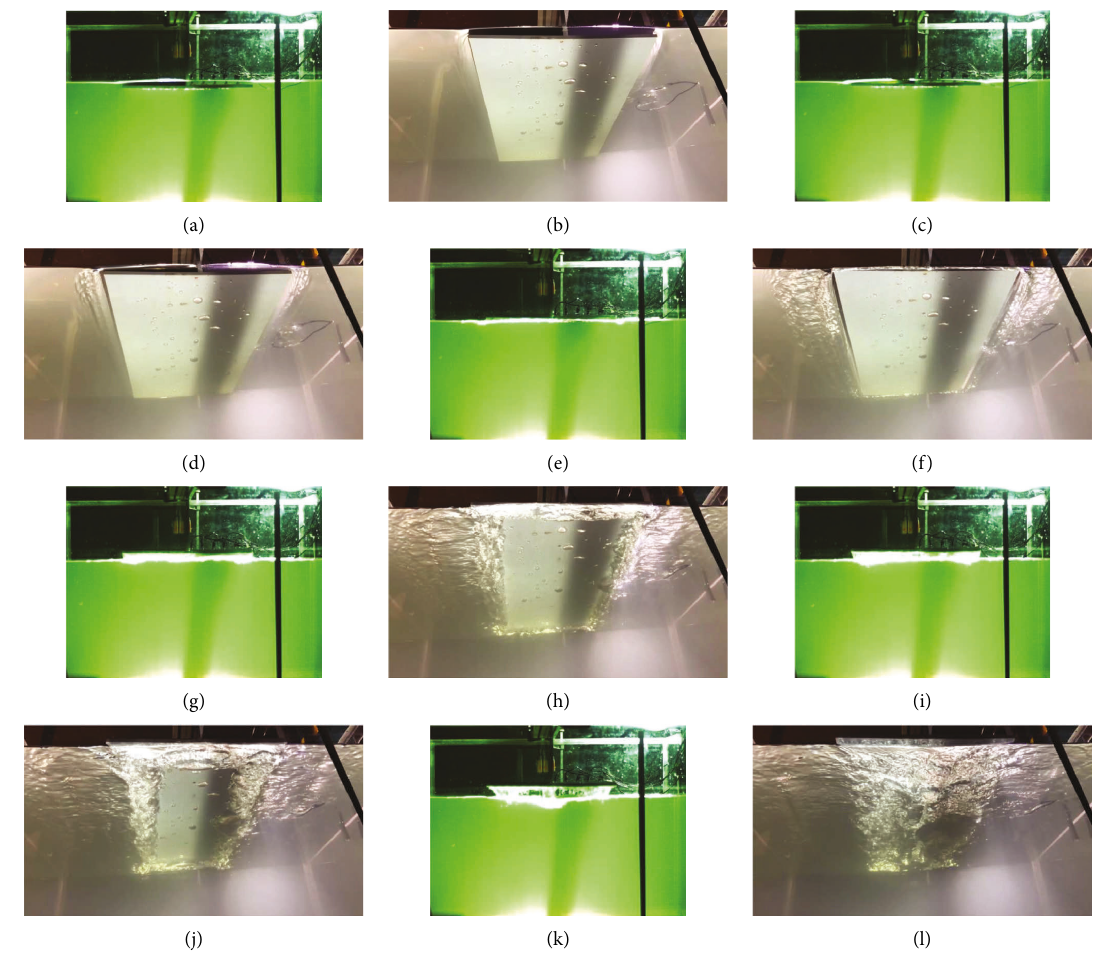
Figure 10: Flow pattern of the suction stage.